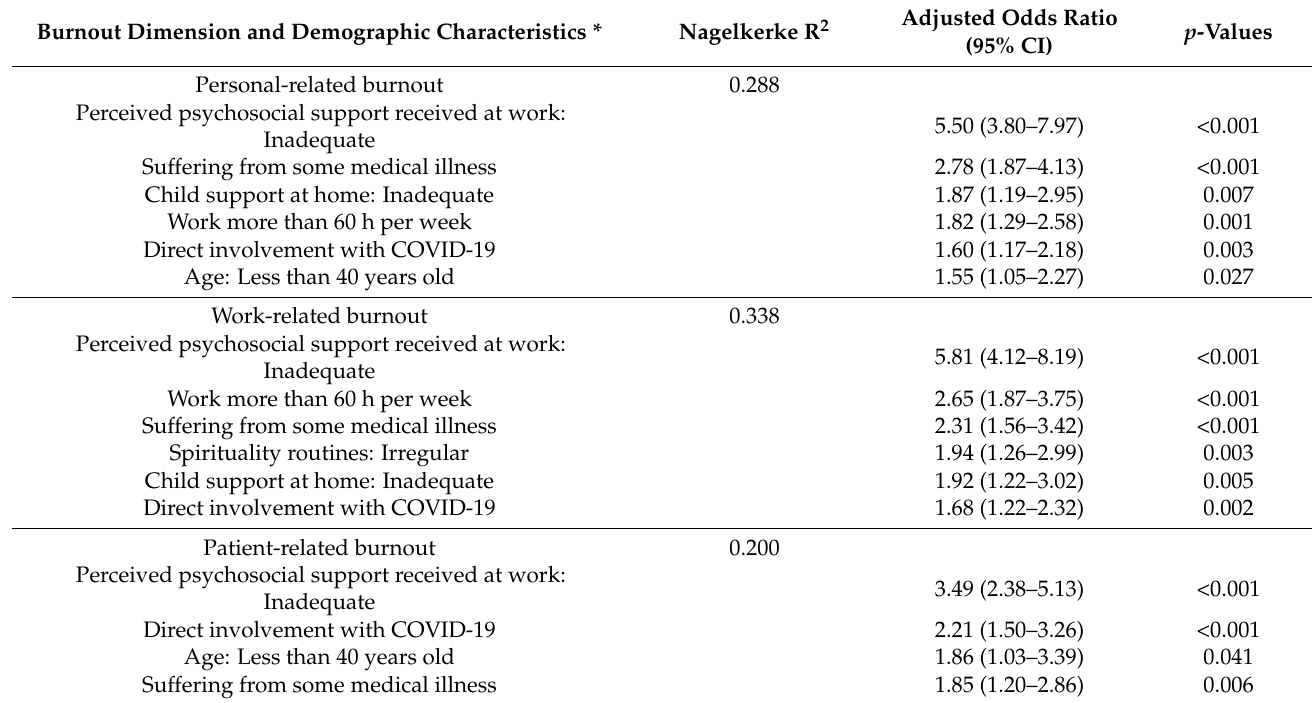
Table 4. Significant associations between the demographic characteristics and burnout using multiple logistic regression ( n = 893). Burnout Dimension and Demographic Characteristics